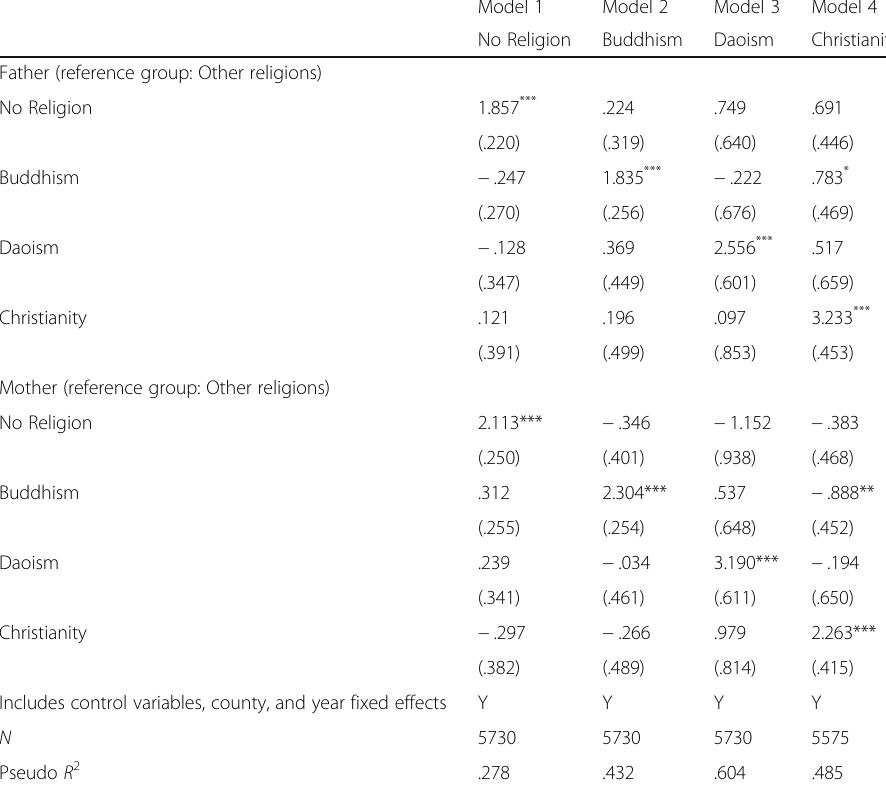
Table 6 Logistic coefficients regressing adult child ’ s religious affiliation on father ’ s and mother ’ s religious